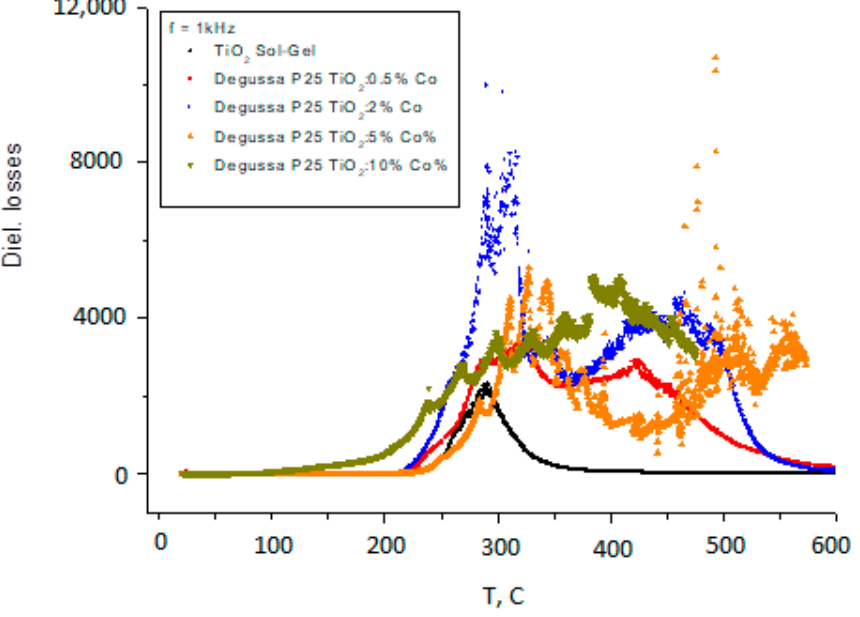
Figure 7. Dielectric losses of Degussa P25 TiO 2 sample doped with different contents of Co. It should be noted the oscillating behavior of the dielectric constant and losses with temperature for the samples with Co content of 5% and 10%. An electrical resistance of the samples is shown in Figure 8.